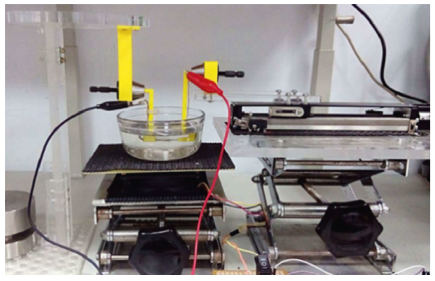
Figure 2: Micro-EDM system.